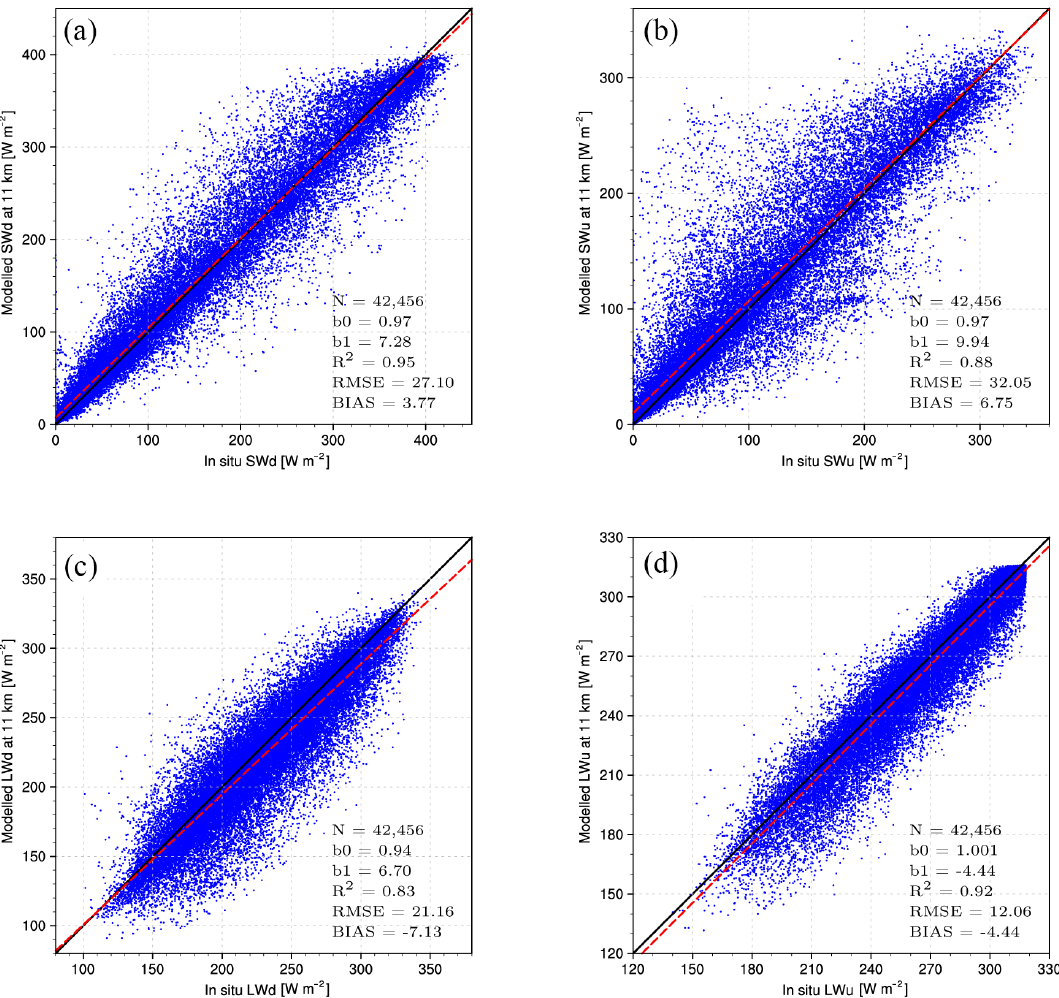
Figure 4. Comparison between daily average modelled (RACMO2.3p2, 2004–2016) and observed (a) shortwave downward, (b) shortwave upward, (c) longwave downward and (d) longwave upward radiation (Wm − 2 ) collected at 23 AWSs (green dots in Fig. 1). For each variable, a regression including all records is displayed as a red dashed line. Statistics including number of records ( N ), the linear regression slope (b0) and intercept (b1), determination coefficient ( R 2 ), bias and RMSE are listed for each